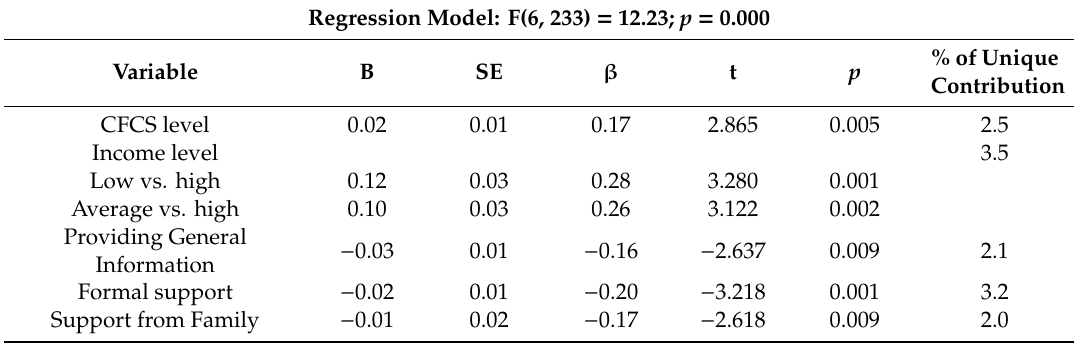
Table 15. Multiple regression model, explaining family needs for